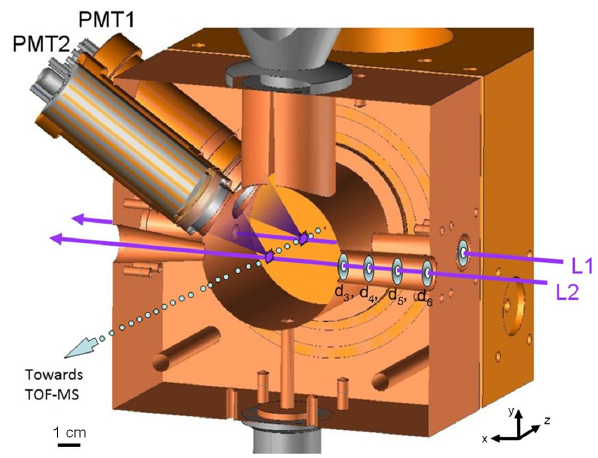
Fig. 3. Optical detection chamber of SPLAM. The particle beam crosses two diode laser beams (L1 & L2). Particle scattered light is detected in forward direction by two photomultiplier tubes at an angle of 34 ± 13 ◦ (centre of active detection area, see Sect. 2.2). The four diaphragms inserted into the tunnels of the incoming laser light avoid the penetration of reflected light from the entrance windows (not shown) into the detection chamber. The laser beams are trapped by light horns (not